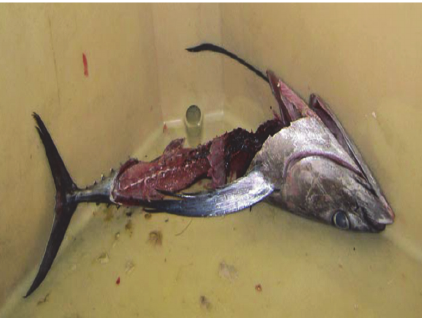
Figure 5: Global usage of fishmeal (adapted from World Bank data)